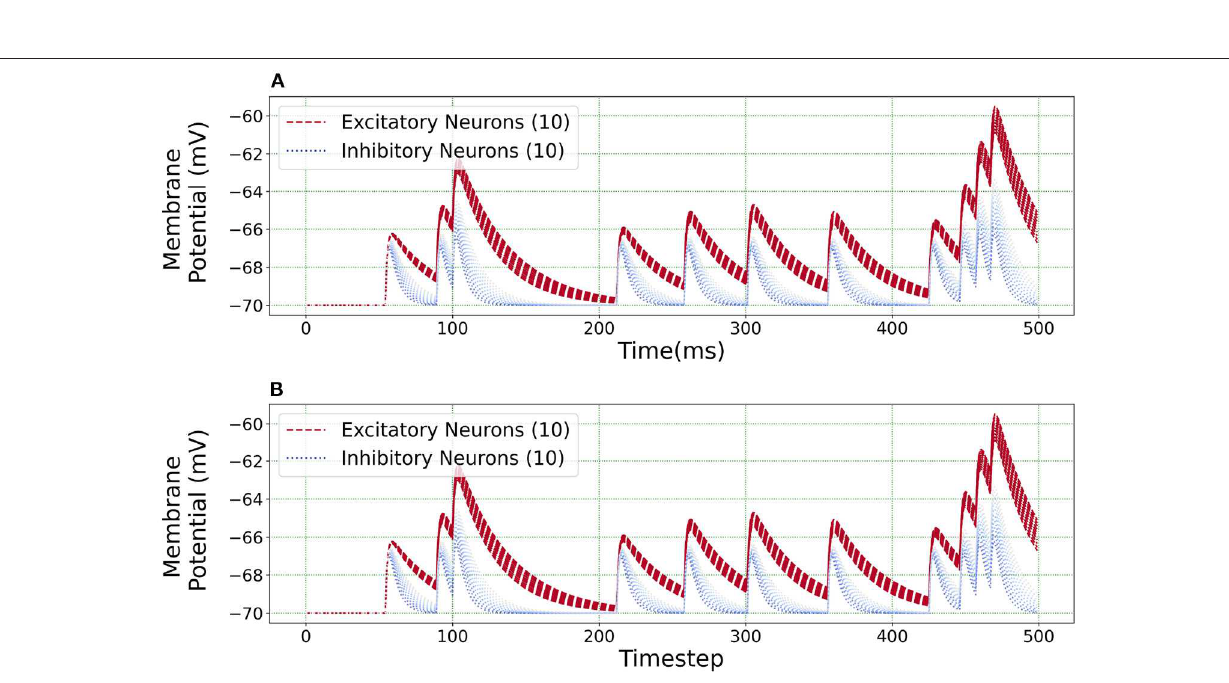
FIGURE 10 | Loihi replicates various neuron class responses of BMTK. (A) BMTK simulation of 20 neuron classes. (B) Loihi simulation of 20 neuron